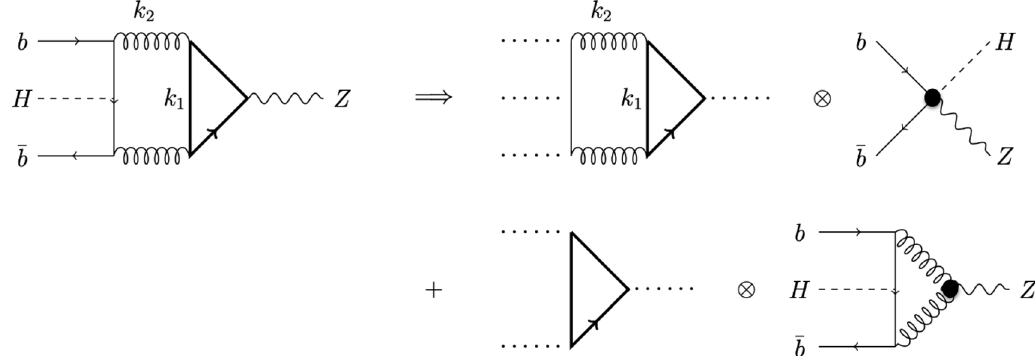
Figure 4 . The heavy-mass expansion of a representative pentagon-triangle diagram with k 1 ; 2 denoting the two loop momenta. The solid thick lines represent the massive t -quark propagators. The dotted lines in the asymptotic irreducible graphs [25] on the left of \ (cid:10) " indicate external momenta which can all be set to zero if only the leading contribution in the limit m t ! 1 is to be kept. The graphs on the right of \ (cid:10) " denote the corresponding co-graphs in the heavy-mass expanded result.